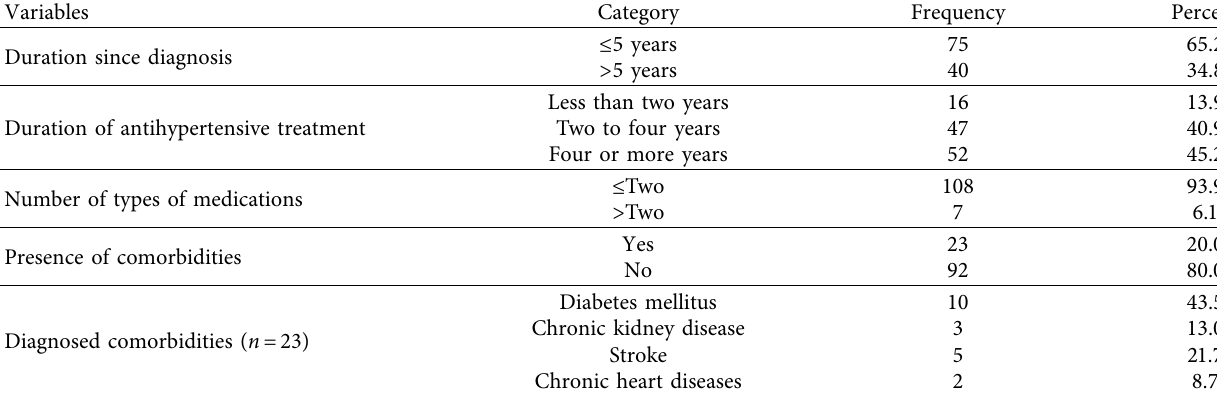
Table 2: Health related factors among hypertensive patients in a follow-up clinic of Asella Referral and Teaching Hospital, Asella Town, Arsi Zone, Oromia Regional State, Ethiopia, 2020 ( n � 115). Variables